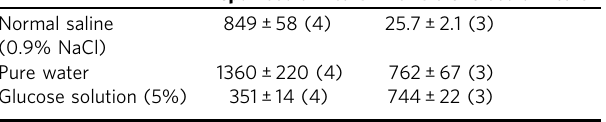
Table 1 Solubilities of Cpd1 sodium salt and dantrolene sodium salt in solutions for